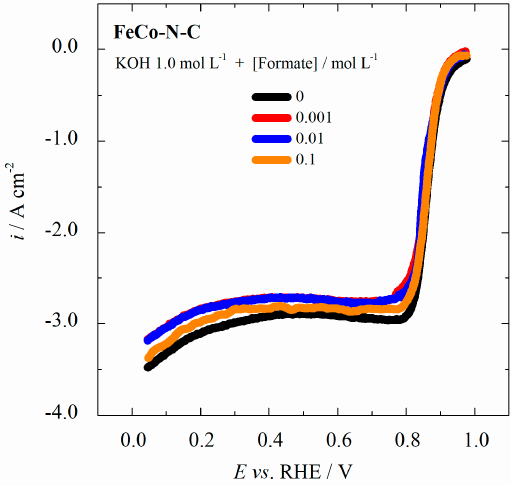
Figure 5. Steady ‐ state polarization curves for the ORR on FeCo ‐ N ‐ C in O 2 ‐ saturated 1.0 mol L − 1 KOH electrolyte, with different concentration of potassium formate, as indicated in the figure inset. Scan rate: 5.0 mV s − 1 . Rotation rate: 1600